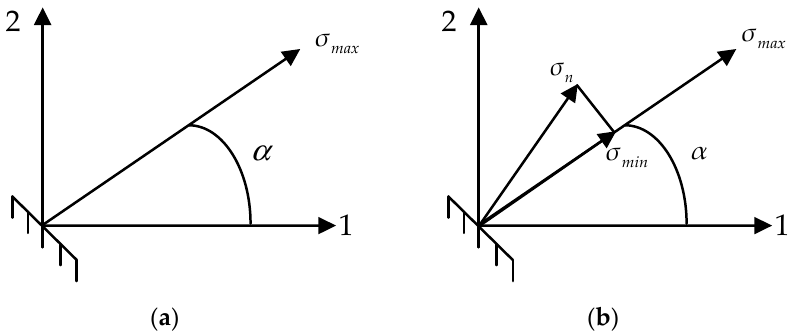
Figure 15. Determination of maximum and minimum principal stresses: ( a ) maximum principal stress; ( b ) minimum principal stress.